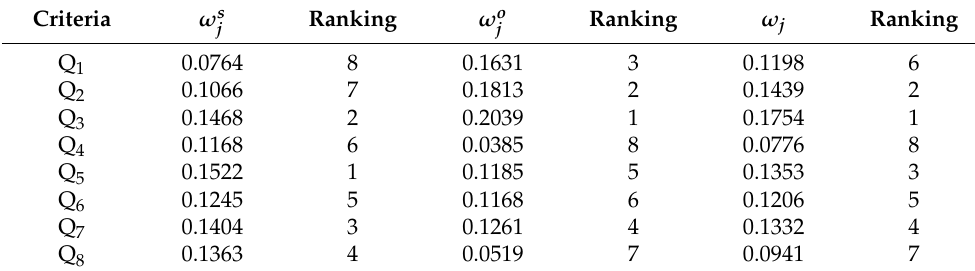
Table 10. The weight of criteria and ranking.